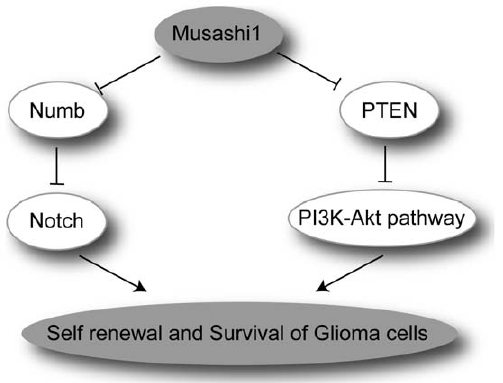
Figure 7. Current model for the involvement of Musashi-1 in glioma development. The elevated level of the RNA-binding protein Musashi-1 leads to the down-regulation of Numb and PTEN (Imai et al., unpublished), resulting in increased activity of the Notch and PI3K/Akt- pathways, respectively. These events could lead to the enhanced self- renewal and survival of glioma cells and subsequent glioma develop- ment. In addition to these mechanisms, the downregulation of Cyclin B1 expression and prolongation of the cell cycle could be involved in Musashi1-mediated glioma development.